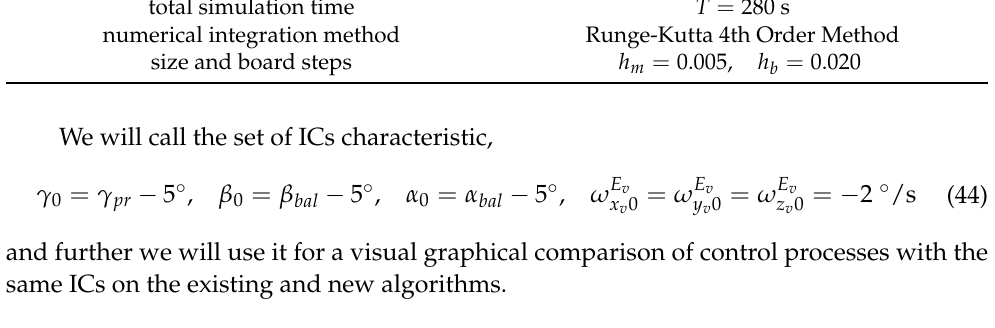
Table 2. Initial Simulation Conditions.